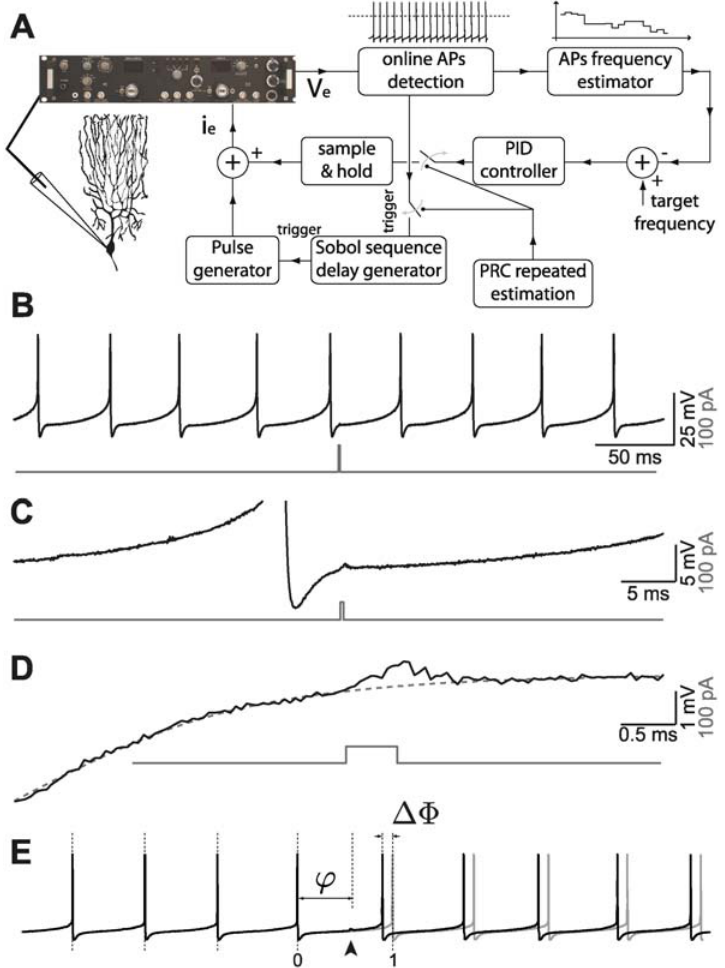
Fig 1. Experimental set-up. (A) A real-time closed-loop in vitro set-up for experimentally estimating the PRC at a fixed firing rate, based on a Proportional-Integral-Derivative (PID) controller and on a reactive-clamp paradigm, was employed to rapidly and optimally explore the dependency of the PRC of PCs on the cell ’ s firing rate. To this aim, a brief external current-pulse (B-D at different scales) was repeatedly delivered at different phases φ of the cell cycle (E), and the resulting impact on the time of the next AP was quantified as a phase delay or of advance Δ φ (E).